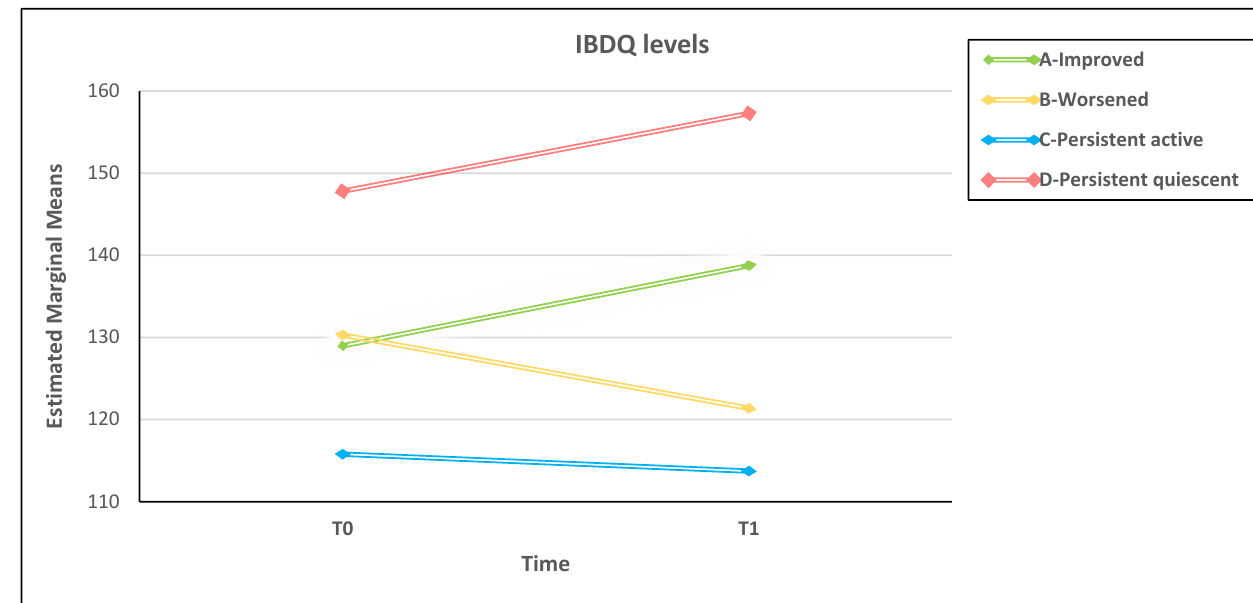
Table 4. Comparisons of HRQoL at T0 and T1 in disease activity change-related groups. Disease Activity-Related Groups